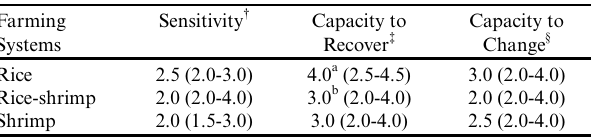
Table 4 . Median values of resilience-related components of agricultural systems for the interviewed farmers in the Mekong Delta (interquartile ranges in parentheses). The values in the table represent a “1-5 Likert scale” standing for very little (1) to very much (5) severity (for the question on the sensitivity to increased salinity intrusion) or ability (for questions on the capacities to recover and to change). No significant difference between farming systems on the sensitivity ( χ ²(2) = 2.08, p = 0.353) and capacity to change ( χ ²(2) = 0.37, p = 0.833); significant difference between farming systems on the capacity to recover ( χ ²(2) = 7.68, p = 0.022) using the Kruskal-Wallis test. The median values with different superscripts are significantly different (p < 0.05, Dunn’s